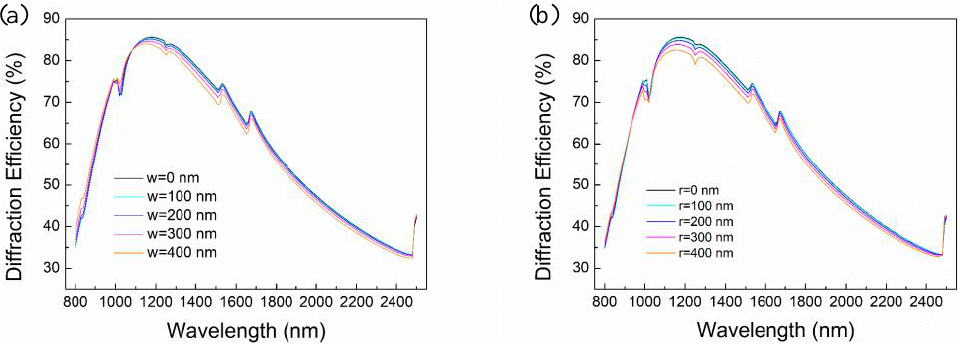
Figure 4. Diffraction efficiency with different ( a ) width of platforms; ( b ) radius of fillets.